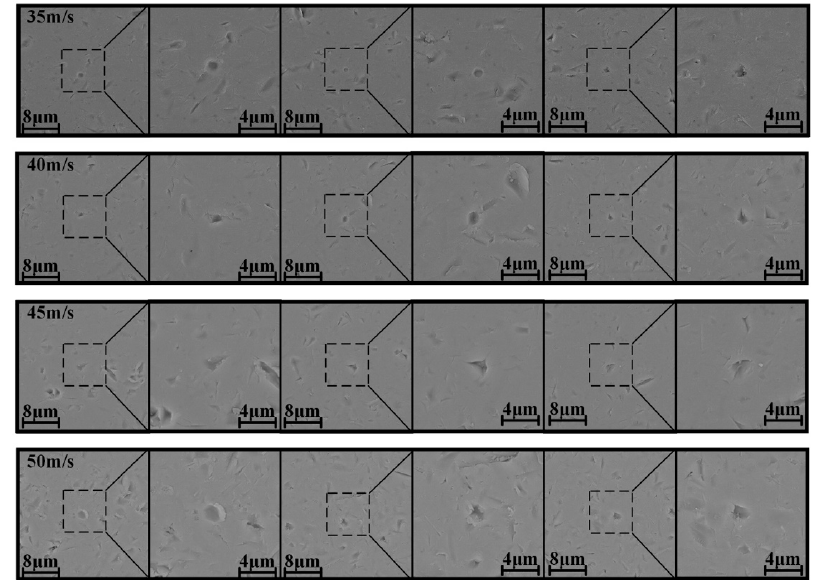
Figure 4. Surface morphology of a single crater under different impact speeds.